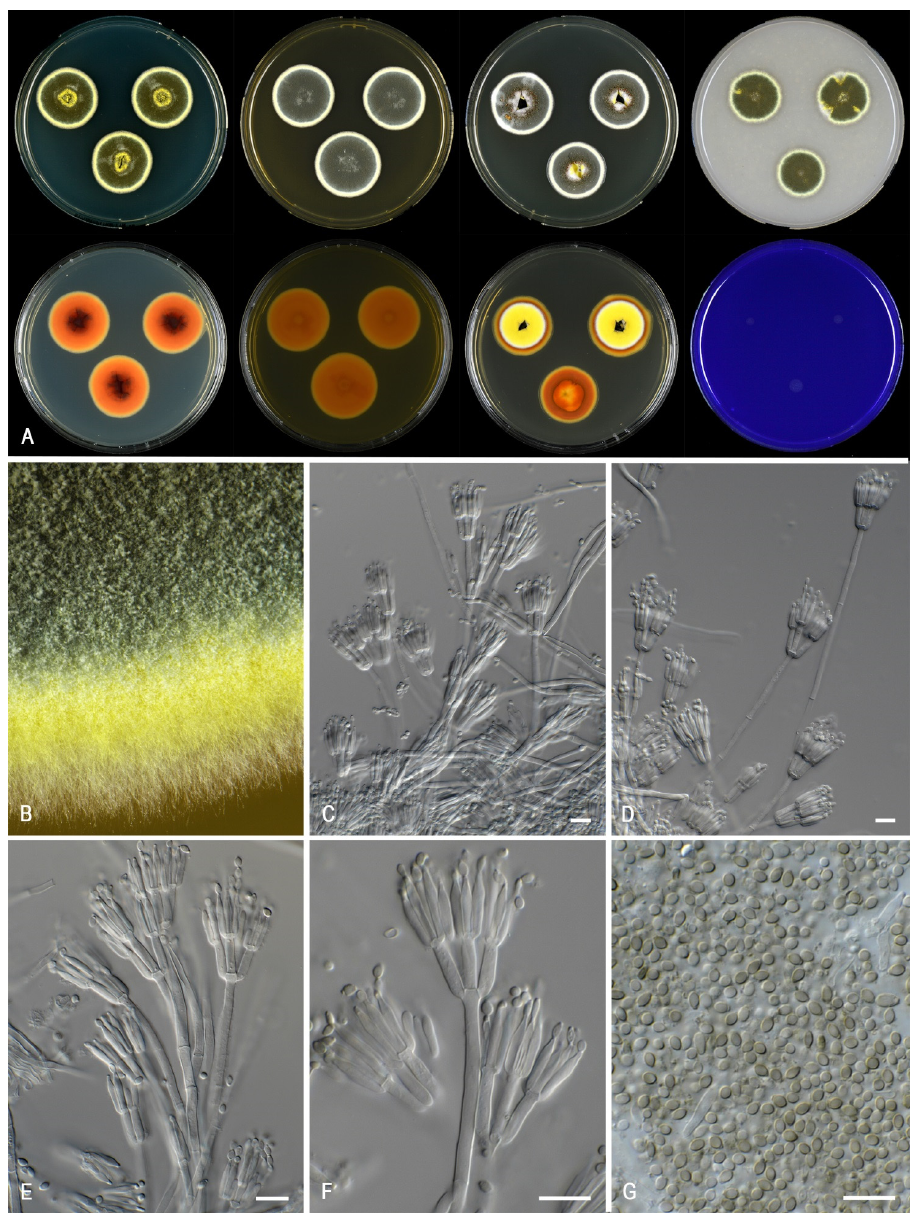
Figure 11. Morphological characters of Talaromyces minnesotensis (CBS 141838). ( A ). Colonies, from left to right, after 7 d at 25 °C (top row) CYA, MEA, YES, OA; (bottom row) CYA reverse, MEA reverse, YES reverse, CREA. ( B ). Detail of colony on MEA. ( C – F ). Conidiophores and conidia. ( G ). Conidia. Scale bars = 10 μ m.